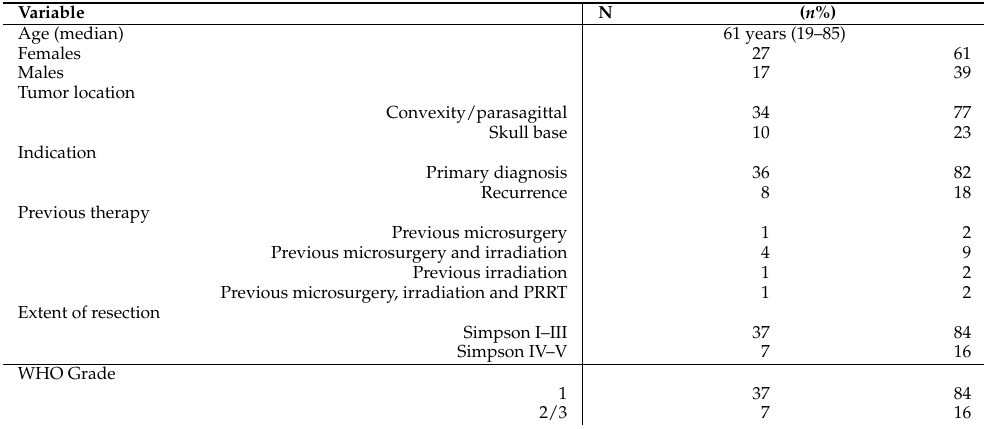
Table 3. Baseline clinical and histological characteristics. Samples included both tumoral and peritumoral tissue. PRRT = Peptide receptor radionuclide